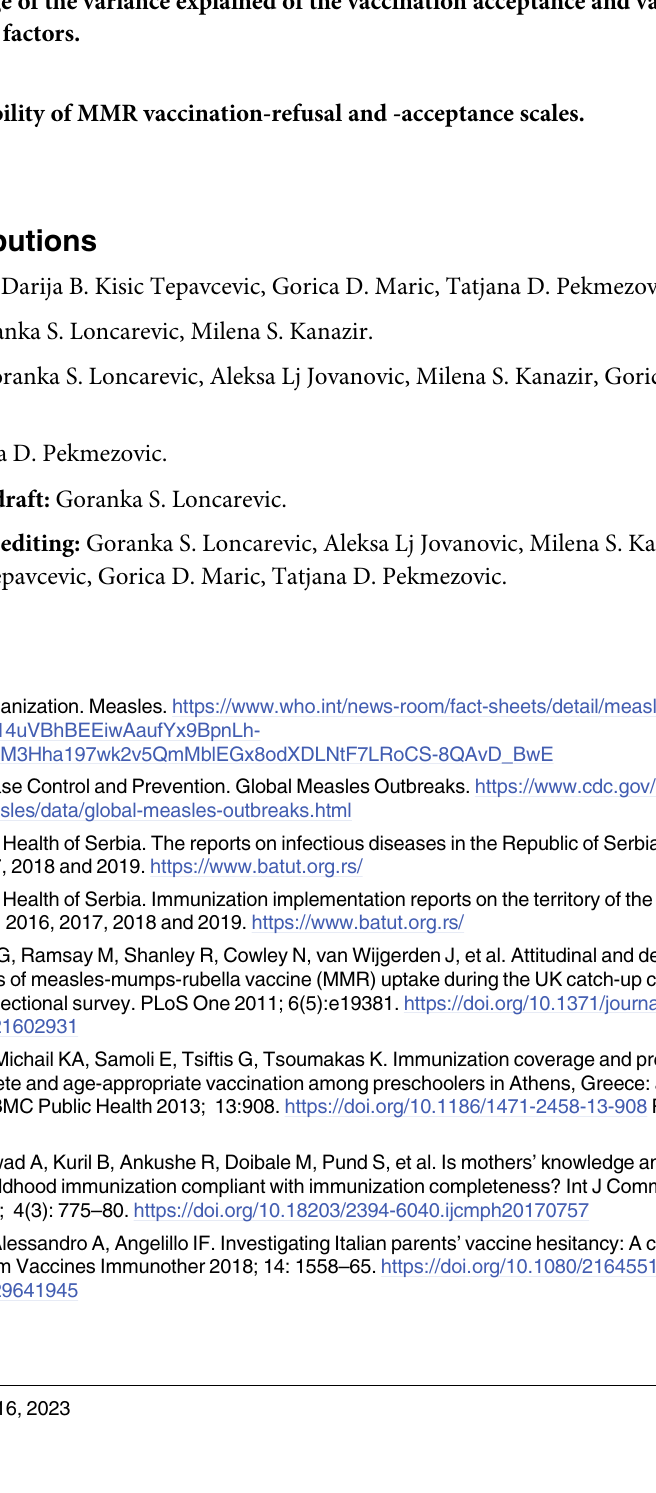
S2 Table. Percentages of correct vaccination knowledge answers. S3 Table. The statements of parents regarding vaccination. S4 Table. Exploratory factor analysis of the reasons for receiving the MMR vaccine for pre- school children. S5 Table. Percentage of the variance explained of the vaccination acceptance and vaccina- tion-refusal related factors. S6 Table. The reliability of MMR vaccination-refusal and -acceptance